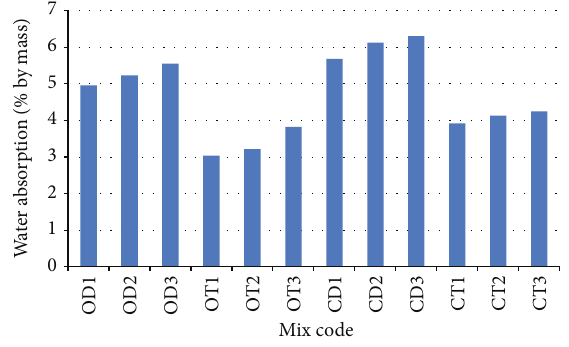
Figure 11: Water absorption of various concrete mixes made from different OPS species and age